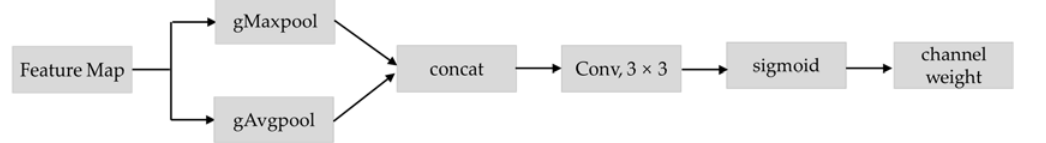
Figure 9. Illustration of the CAM module: gMaxpool and gAvgpool stand for global maximum pooling and global average pooling, respectively.